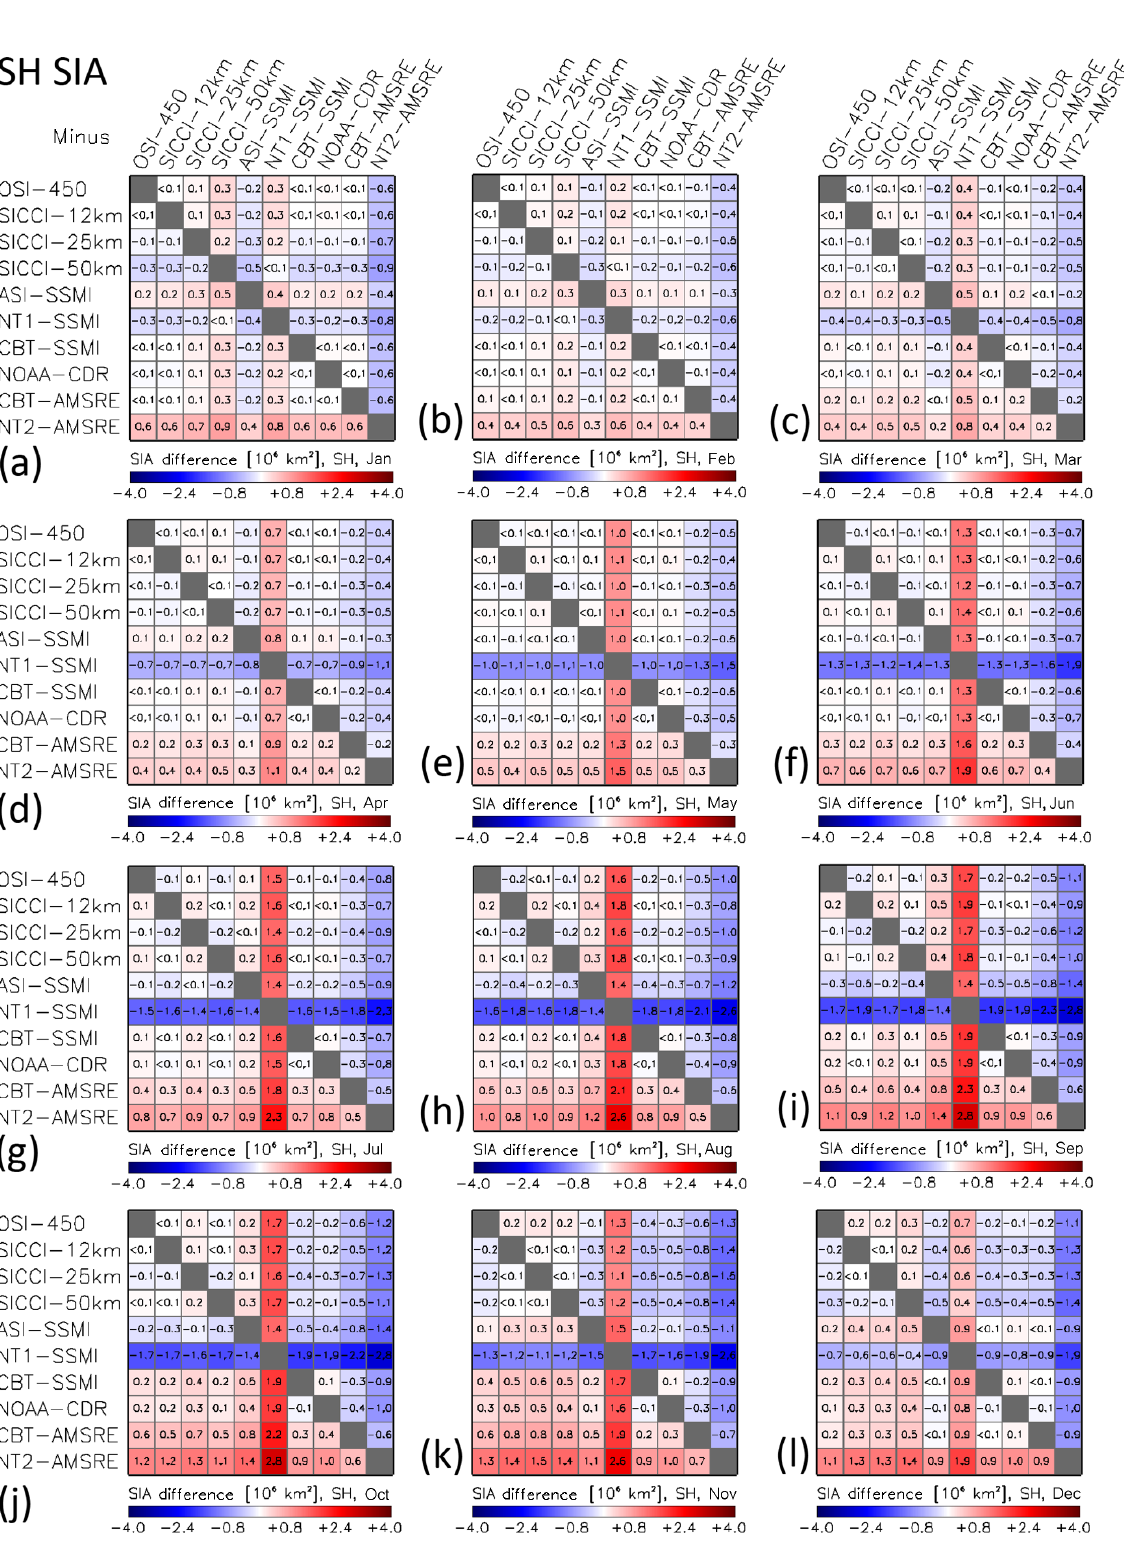
The Cryosphere, 13, 3261–3307, 2019